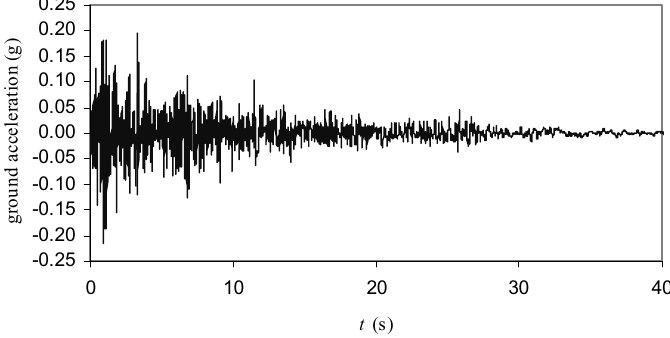
Fig. 9. Accelerogram from 1940 El Centro earthquake (vertical component).